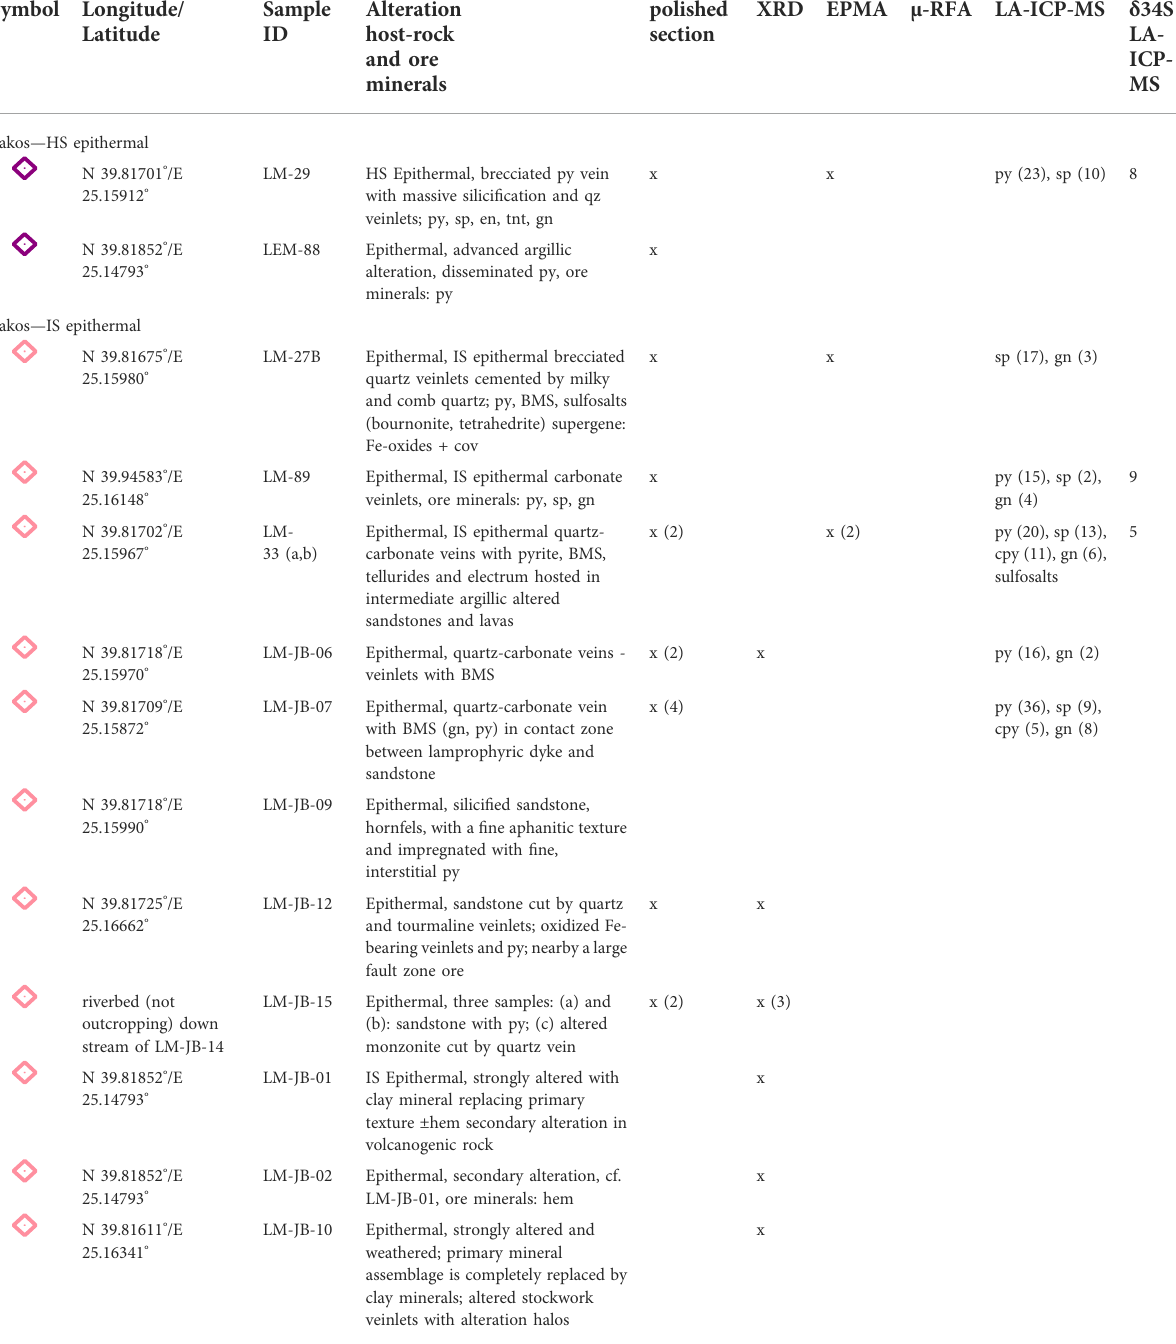
TABLE 2 Compilation of the Fakos HS and IS epithermal samples investigated in this study with respect to sample, sampling site, alteration type, mineralogy and applied analytical techniques. Symbol Longitude/